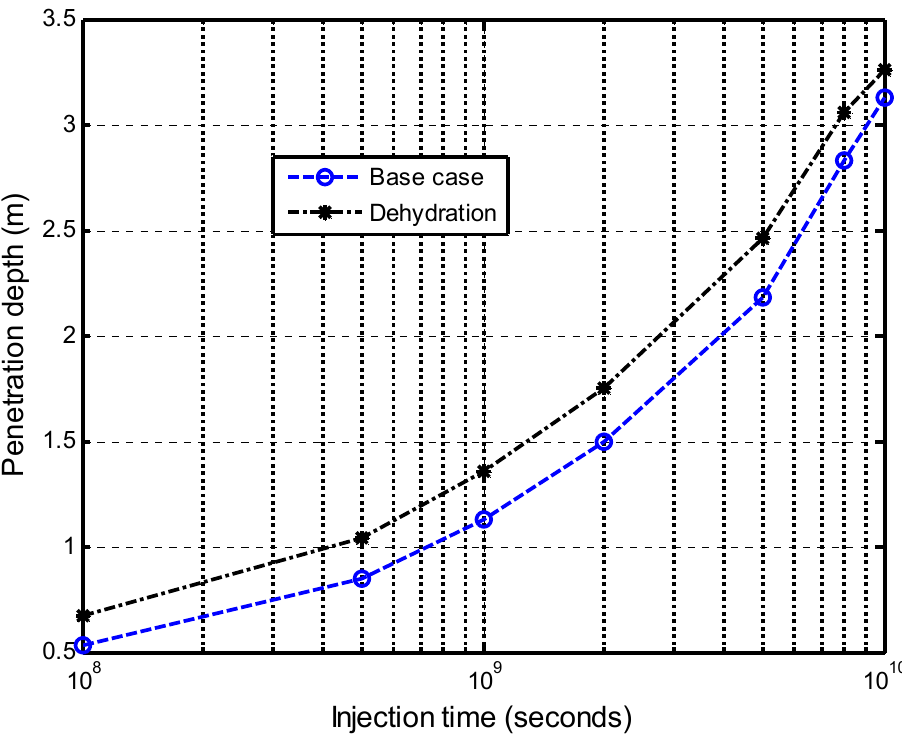
Figure 13. Effect of dehydration on the penetration depth.